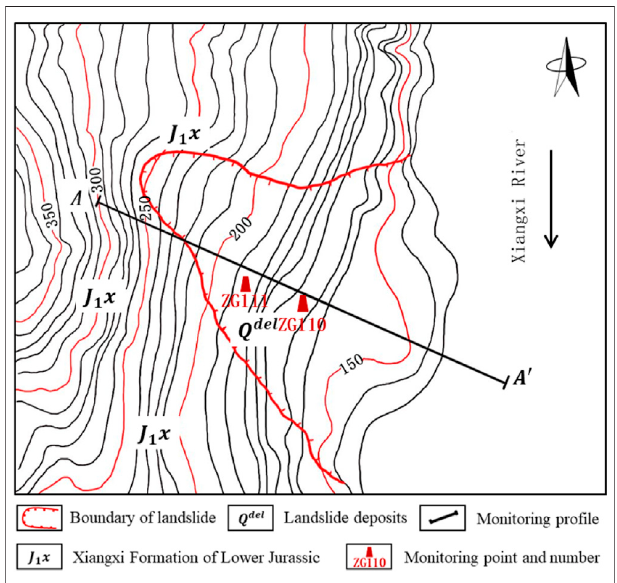
FIGURE 1 | Illustration of the monitoring layout in the Bazimen landslide